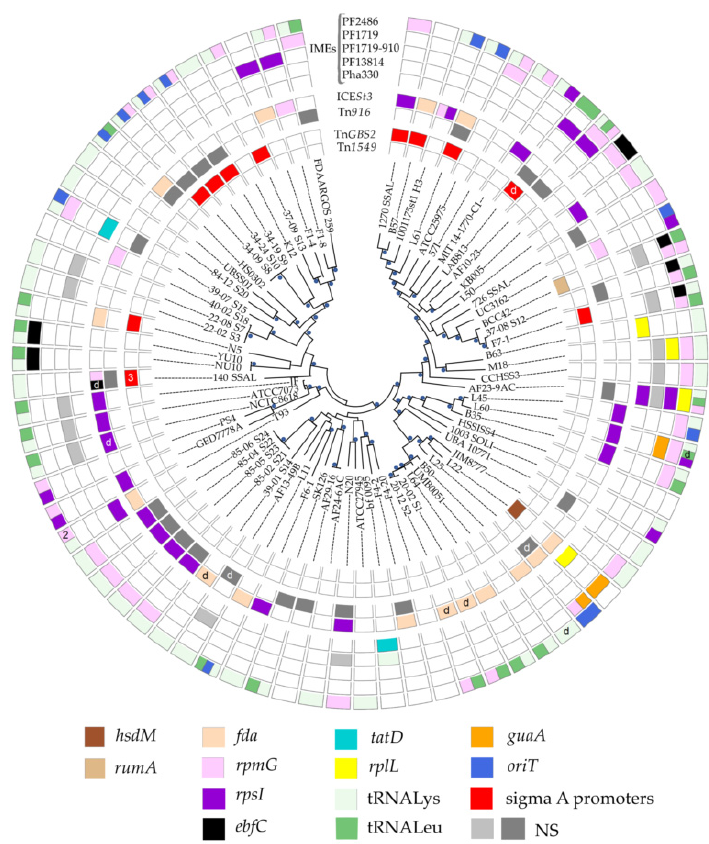
Figure 1. Integrative and conjugative elements (ICEs) and integrative and mobilizable elements (IMEs) carried by S. salivarius genomes. Strains are indicated in the middle of the circle and were grouped according to their phylogenetic relatedness. Groupings with bootstrap values >90 are marked with blue dots. Boxes located in front of a strain name are either empty (absence of element) or colored (presence of an ICE or an IME). The different families of ICEs and IMEs are indicated at the top in the opening of the circle. The first four inner circles indicate the presence of elements belonging to the four distinct families of ICEs retrieved in this study. The five outer circles show the presence of IMEs, where each line corresponds to one IME superfamily. Defective ICEs or IMEs are indicated by a “d.” The box is split in two (or more) when two elements (or more) of the same superfamily are present at distinct integration sites. If several elements of the same superfamily are present at the same integration site, the number of elements is indicated in the box (for example, two IMEs with a PF02486 domain in strain T93). The colored boxes indicate the genes where the elements are inserted. The medium-grey boxes materialize low-specific integration